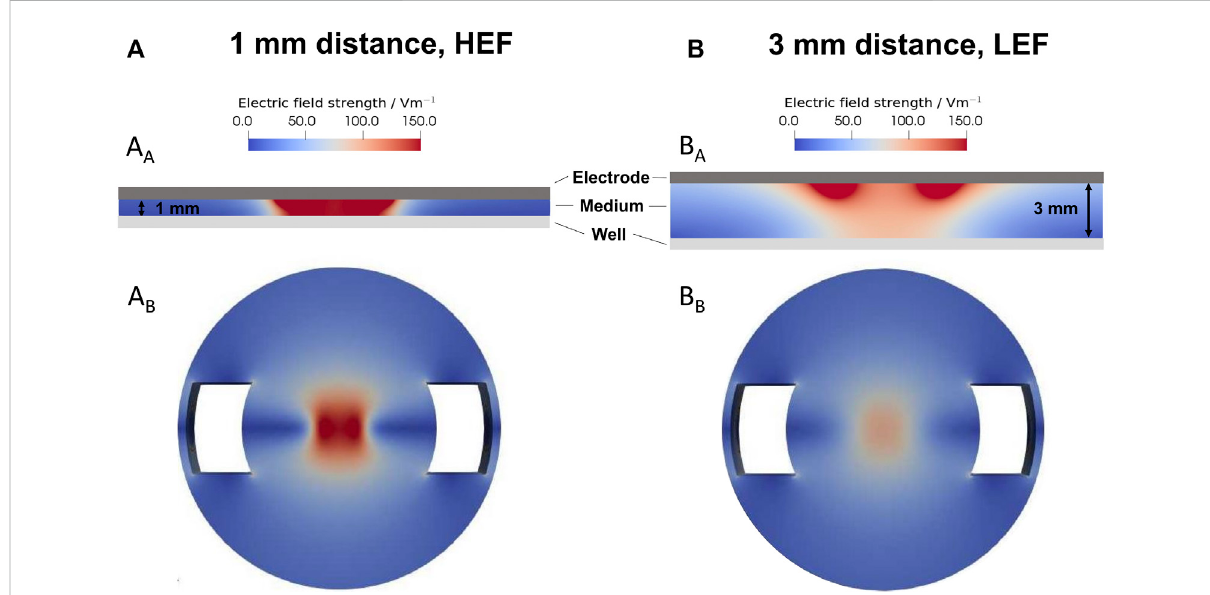
FIGURE 2 Simulation of the electric fi eld using a sinusoidal signal with 20 Hz and 0.7 V rms . (A) Distribution of the electric fi eld with a distance of 1 mm, leading to a higher electric fi eld (HEF) (B) Distribution of the electric fi eld with a distance of 3 mm, resulting in a lower electric fi eld (LEF). A A and B A distribution of the electric fi eld between the electrode and the well ’ s bottom. A B and B B electric fi eld distribution on the well ’ s bottom. The 1 mm distance results in a higher electric fi eld up to 150 V/m, and the 3 mm distance results in a lower electric fi eld up to 100